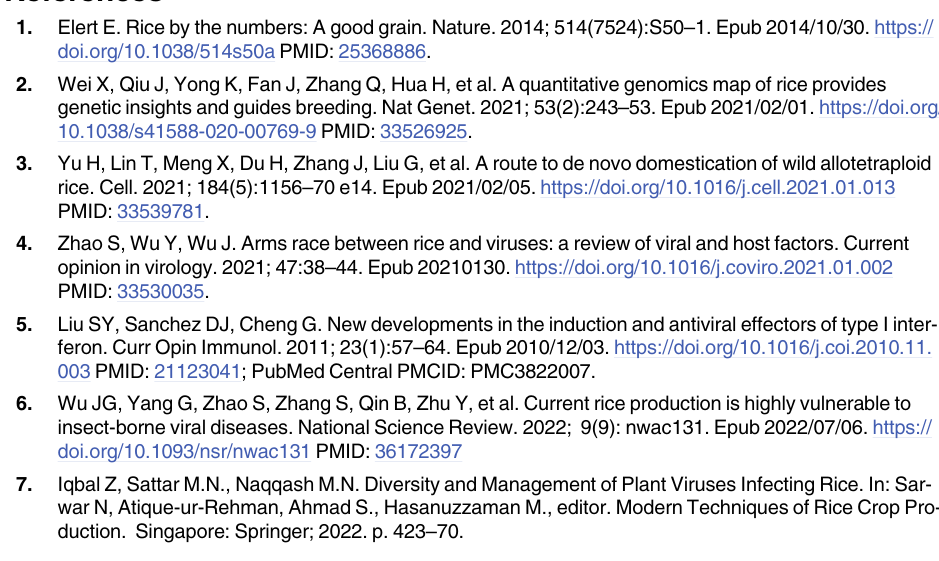
S1 Table. RTIV full-length sequences. Subgenomic region (2449nt from 3466st to 5914st) is red-colored. S2 Table. List of viruses. Known viruses in Sobemoviridae used for analysis of phylogenetic tree and sequence similarity with RTIV. S3 Table. List of primers. All primers used for different PCR amplifications in this